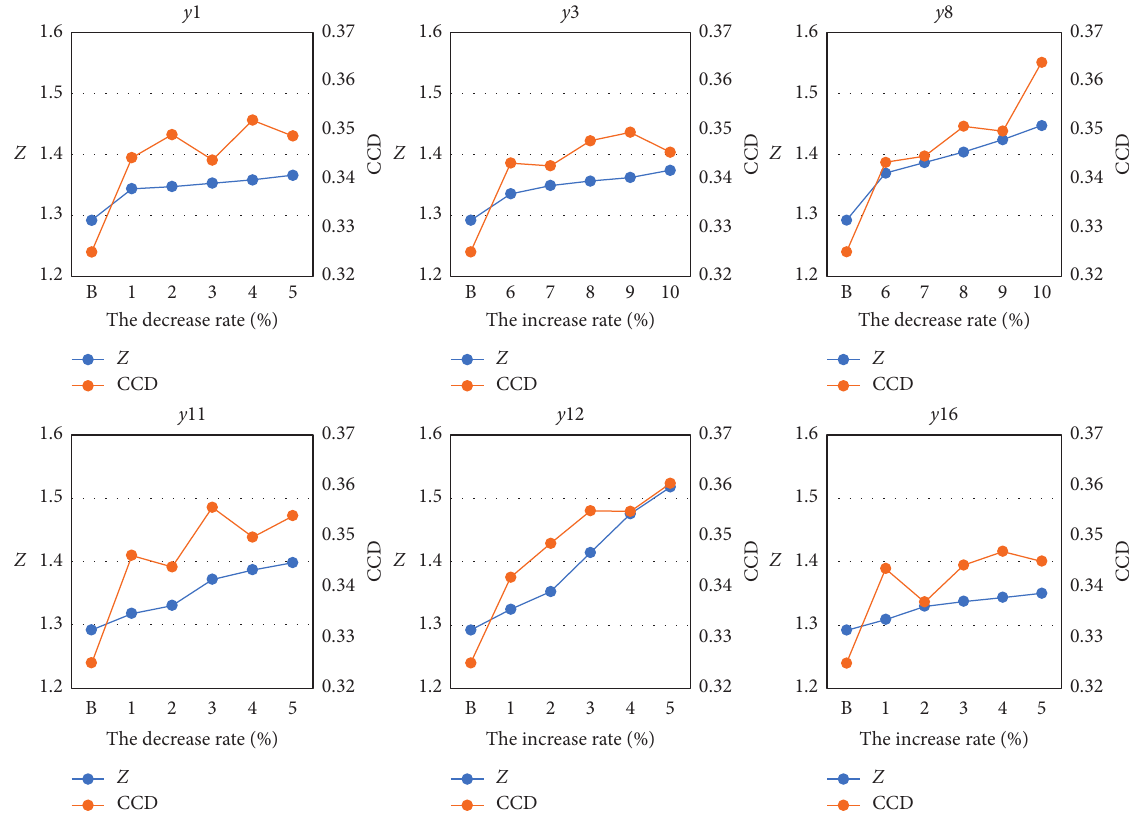
Figure 6: Z and CCD under the change rate of six key